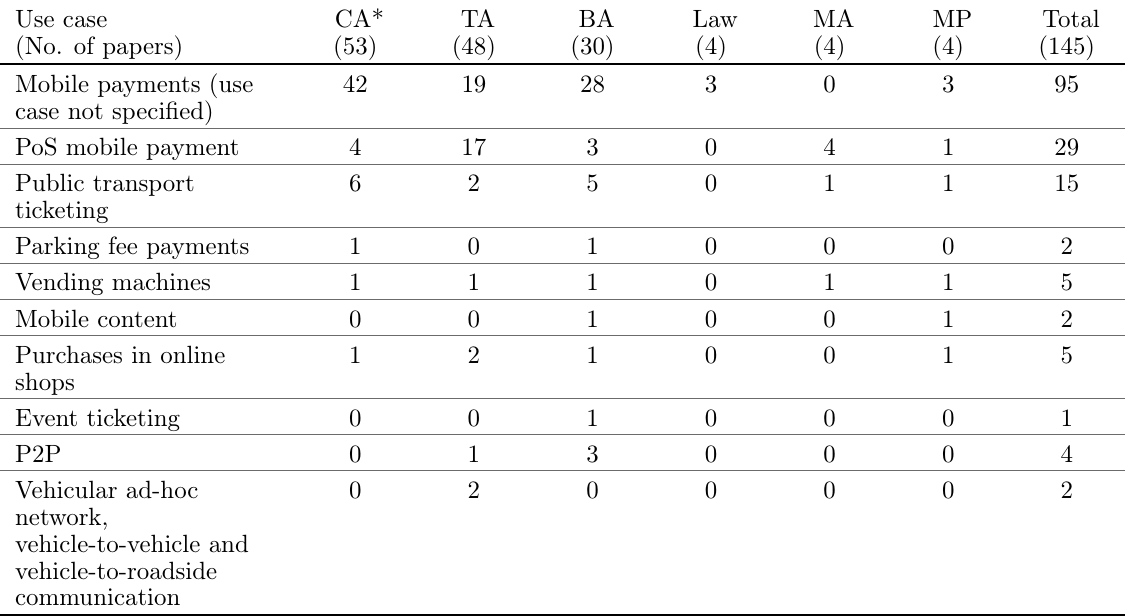
Table A.2. Mobile payment technologies discussed in selected